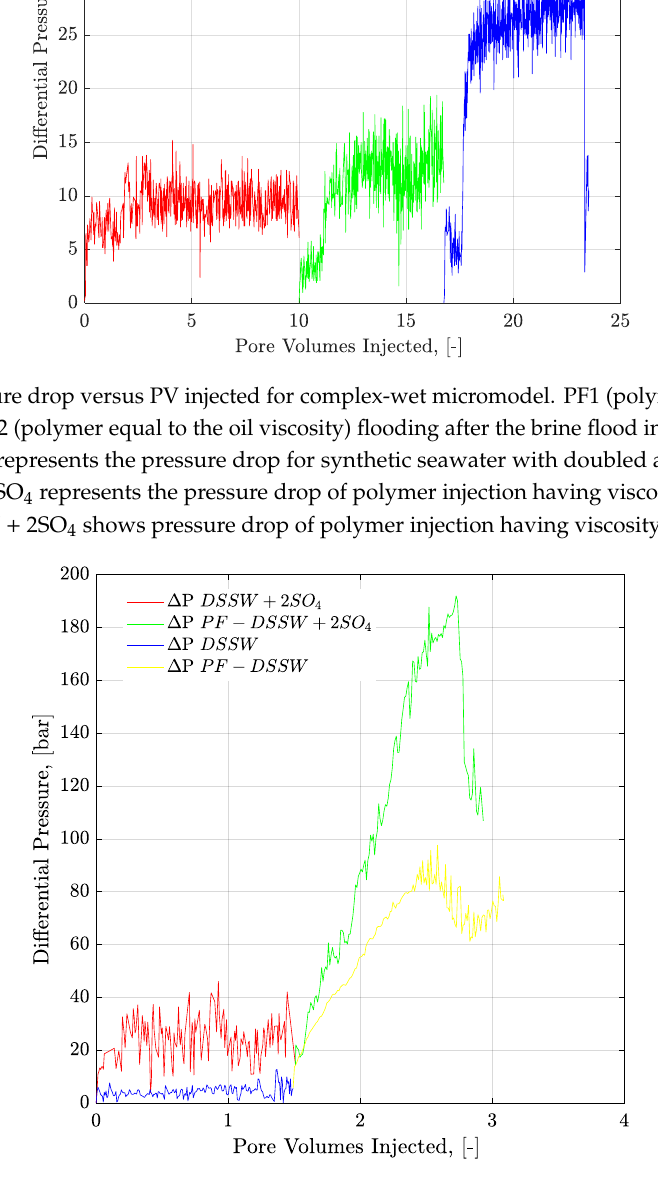
Figure 18. Pressure drop versus PV injected for three-weeks aged core plugs. Brine injection (≈5 g/l TDS) is performed in secondary mode while polymer flood (half to the oil viscosity) in the tertiary mode. ΔP DSSW + 2SO 4 represents the pressure drop for ten times diluted synthetic seawater with double amount of sulfates. ΔP PF-DSSW + 2SO 4 represents the pressure drop from polymer injection having viscosity half to the oil and prepared in ten times diluted synthetic seawater with double amount of sulfate. DSSW denotes pressure drop for ten times diluted synthetic seawater.